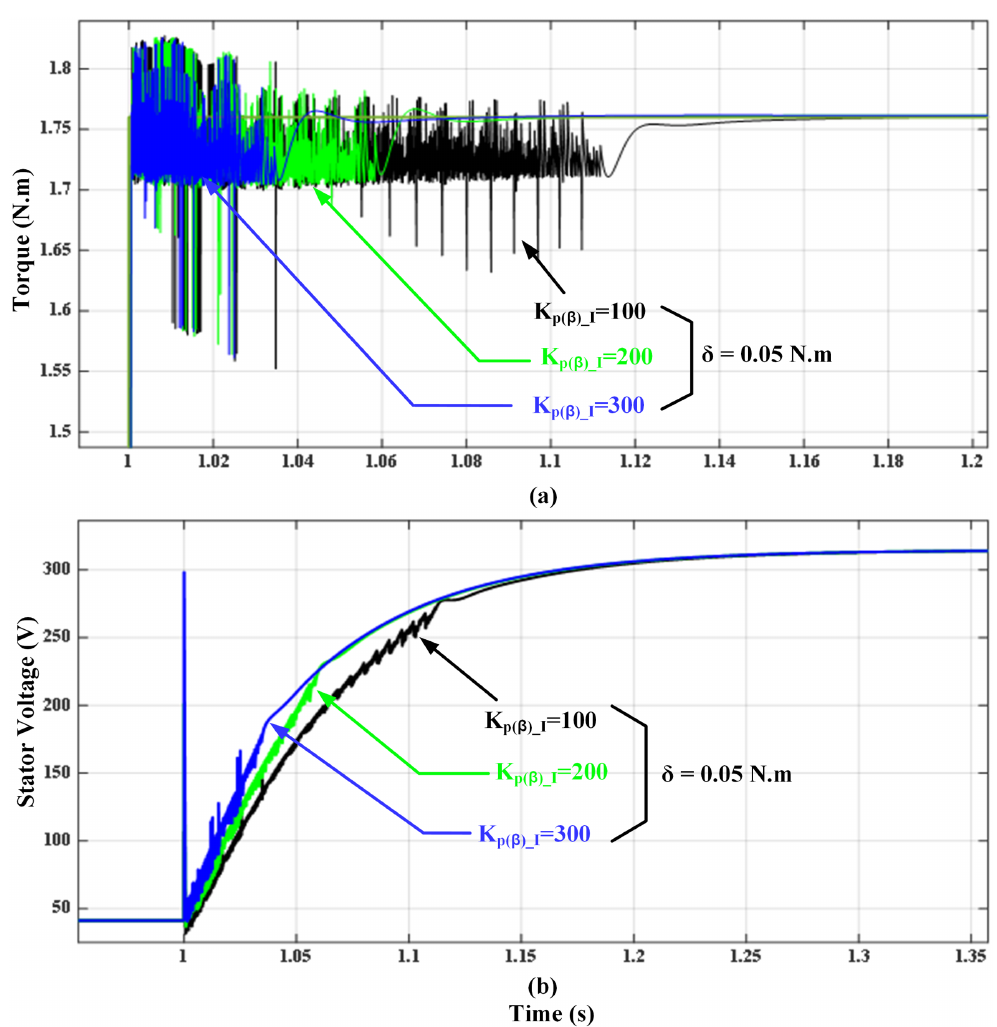
Figure 25. ( a ) Torque response of the proposed combined FOC-DTC algorithm for three values of K P ( β ) − I . ( b ) Stator voltage vector modulus V s in the FOC